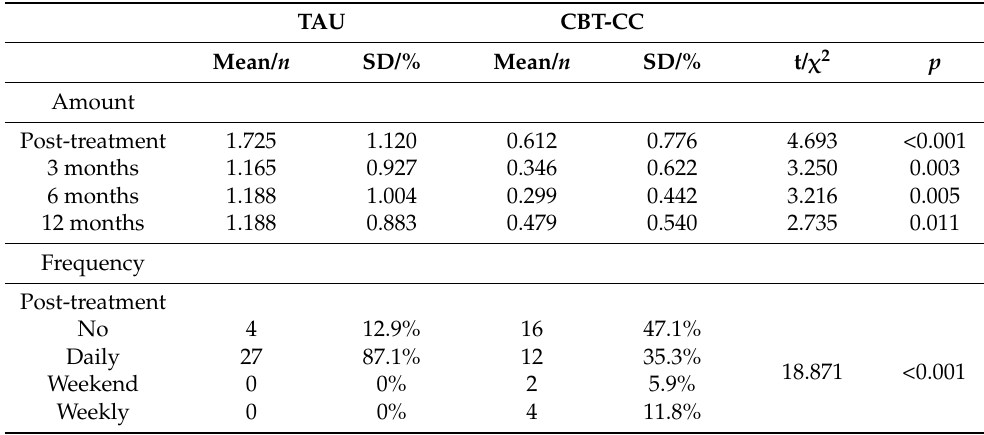
Table 4. Frequency and amount of cannabis use throughout the